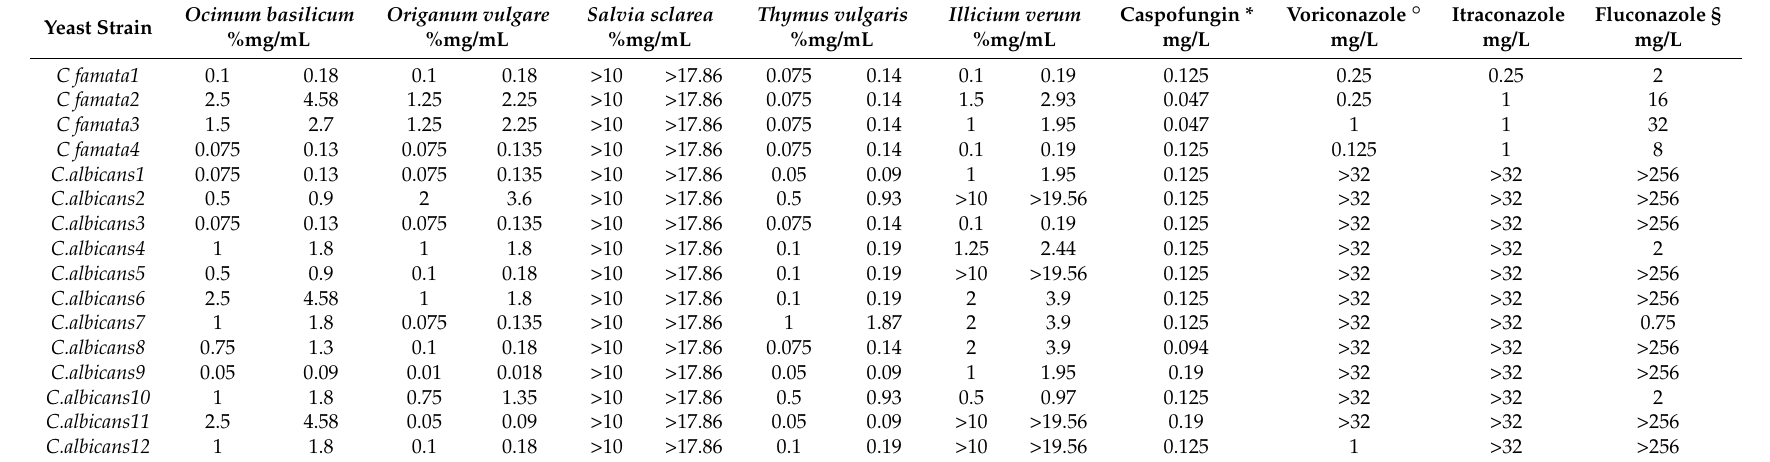
Table 5. MIC values of selected essential oils, expressed as percentage and